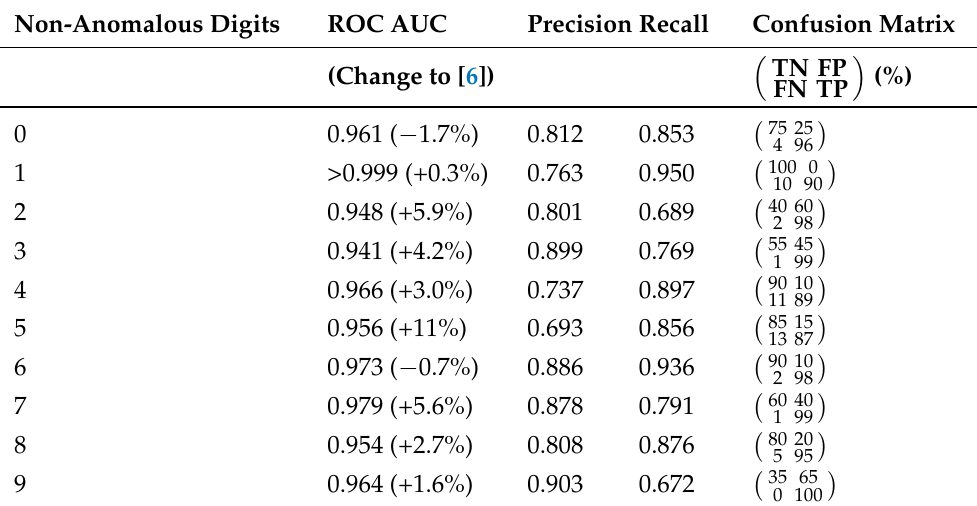
Table 5. Results for anomaly detection on multi-perspective MNIST [9] dataset using the denoising early fusion technique. True positive samples (TP) are anomalous, etc. Additionally, the relative changes of the ROC AUCs w.r.t. to the original Deep SVDD [6] are shown.